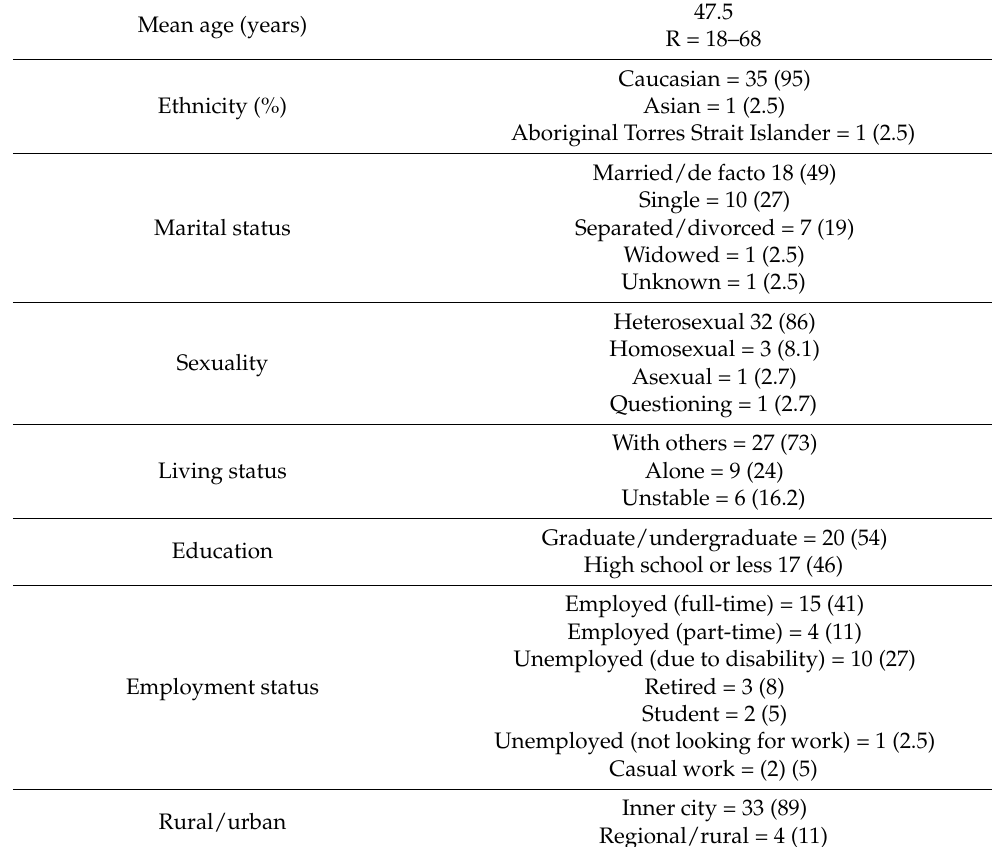
Table 1. Participant demographics (n = 37